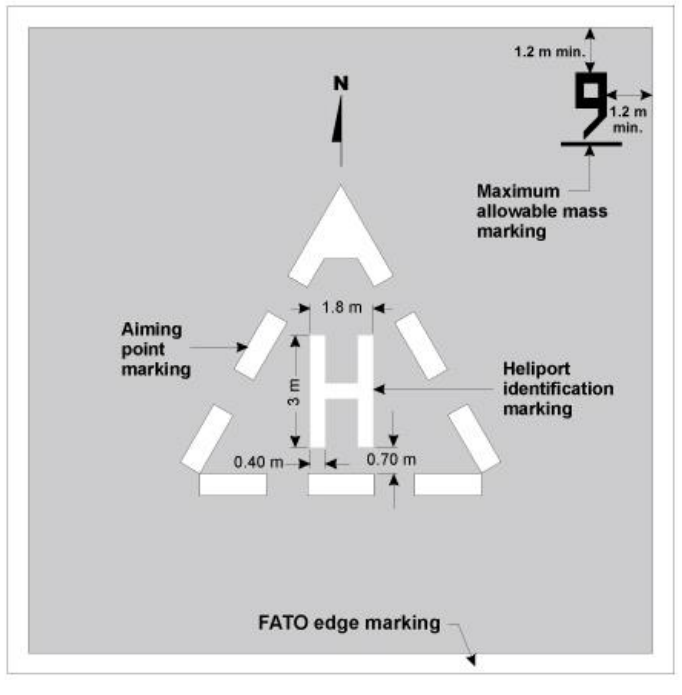
Figure 3. Heliport identification markings